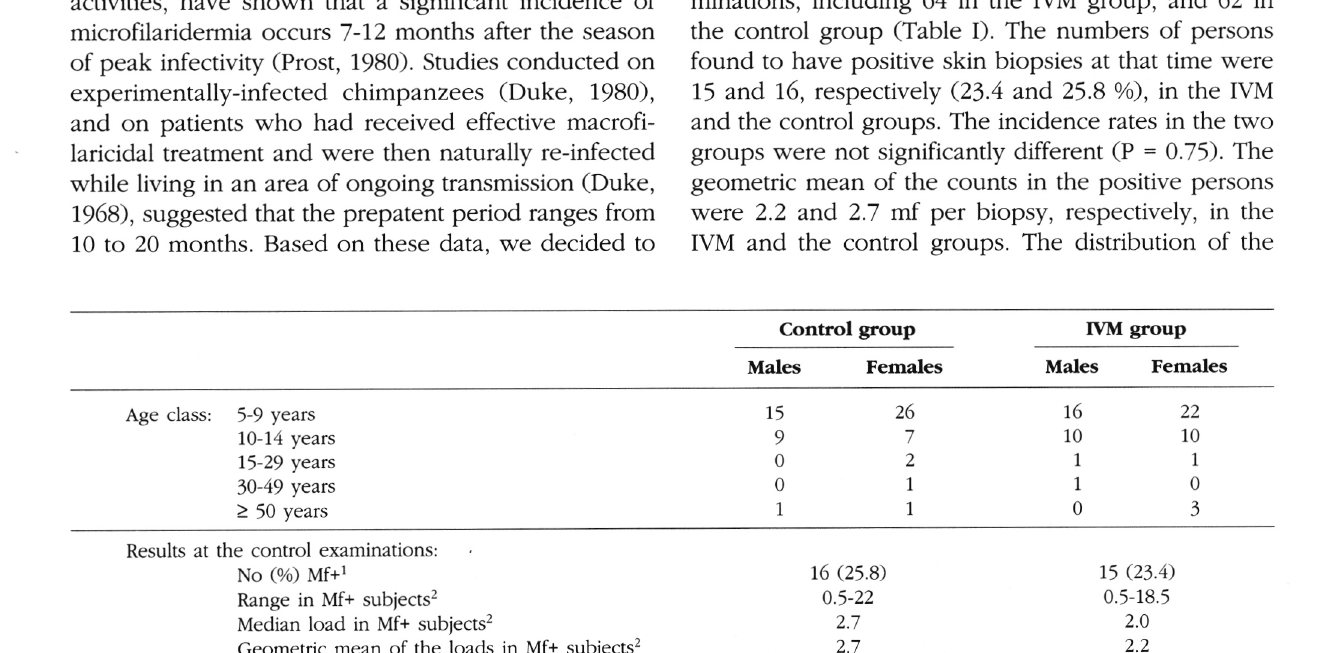
Table I. - Results of skin examination for Onchocerca volvulus microfilariae in patients who had initially negative skin biopsies, and who had been treated 12 months previously either with ferrous sulphate (control group), or with a combination of ivermectin (150 yg/kg) + ferrous sulphate (IVM